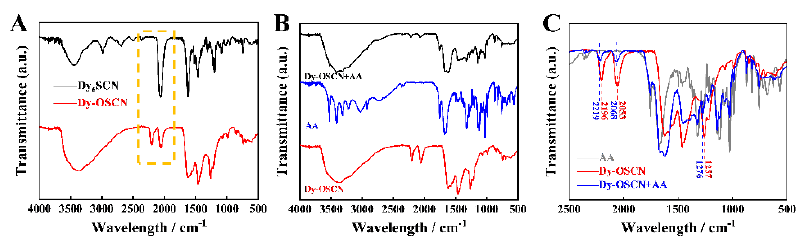
Figure 6. The Fourier transform infrared (FTIR) spectrum of ( A ) Dy 6 − SCN and Dy − OSCN; ( B ) Dy − OSCN monocrystal before and after (unwashed) binding with AA; ( C ) a larger version of A (500 − 2500 cm − 1 ).